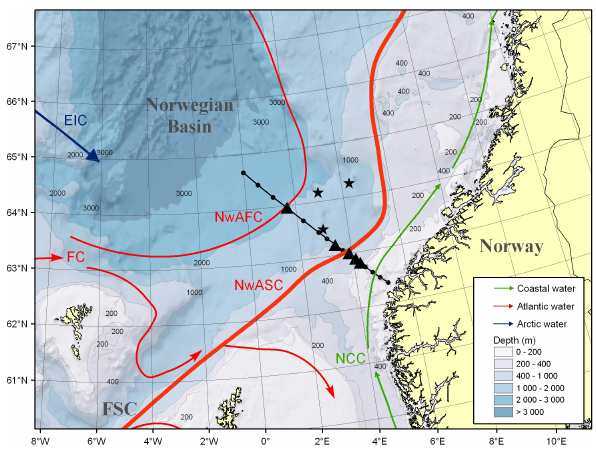
Fig. 1. Map of the study area in the southern Norwegian Sea. The locations of the Svinøy section (black line) with the 17 hydro- graphic stations (black dots) are shown. The current measurements from Orvik et al. (2001, black triangles) and the Norwegian Deep Water Programme, Lønseth et al. (2003, black stars) used for vali- dation are also illustrated. See Table 1 for more details of the cur- rent measurements. The Faroe-Shetland Channel (FSC), Faroe cur- rent (FC), the two branches: the Norwegian Atlantic Slope Current (NwASC) and the Norwegian Atlantic Front Current (NwAFC), the Norwegian Coastal Current (NCC), and the East Icelandic Current (EIC) are also